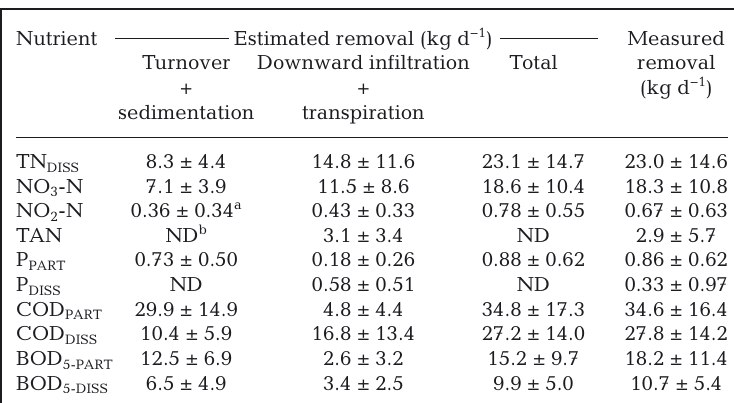
Table 3. Estimated and measured mass nutrient removal (mean ± SD, n = 26). Turnover + sedimentation derived as: (inlet concentrations − modelled